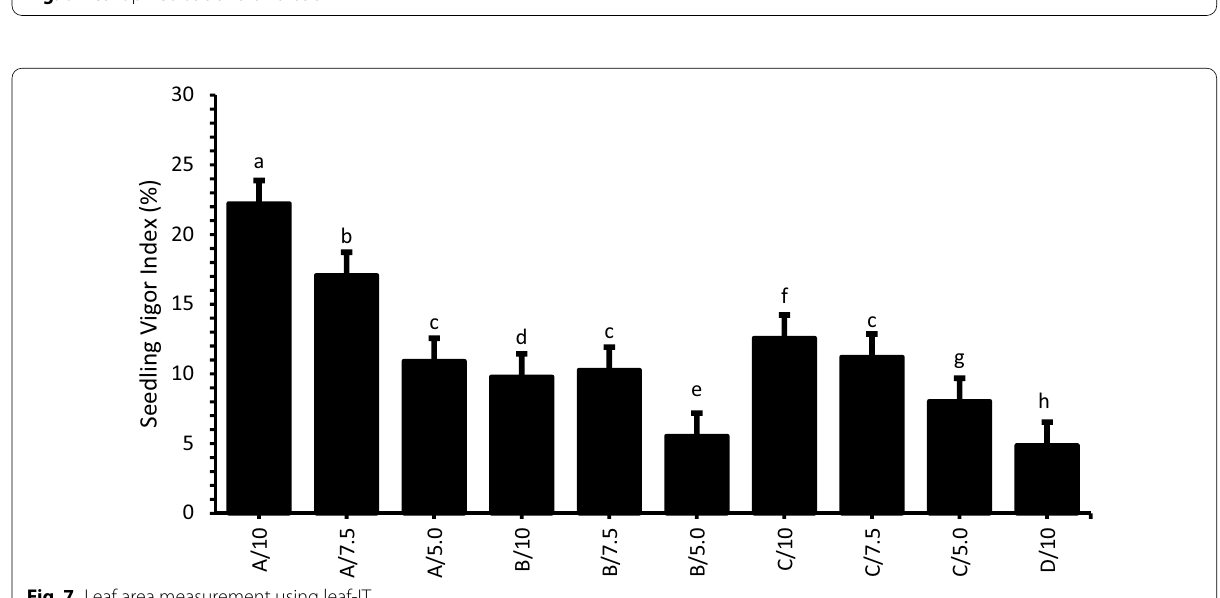
Fig. 6 Leaf tip necrosis and chlorosis